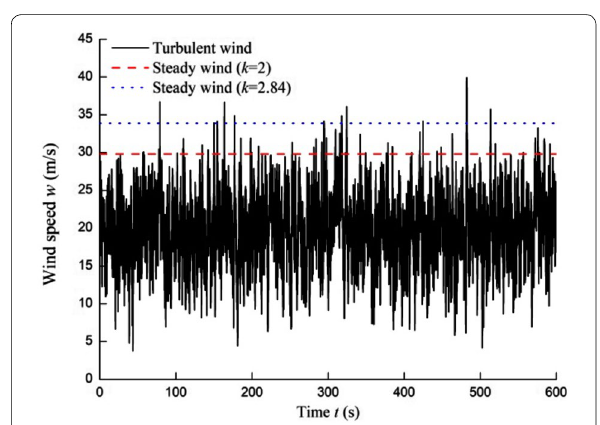
Figure 9 Aerodynamic side force for gust